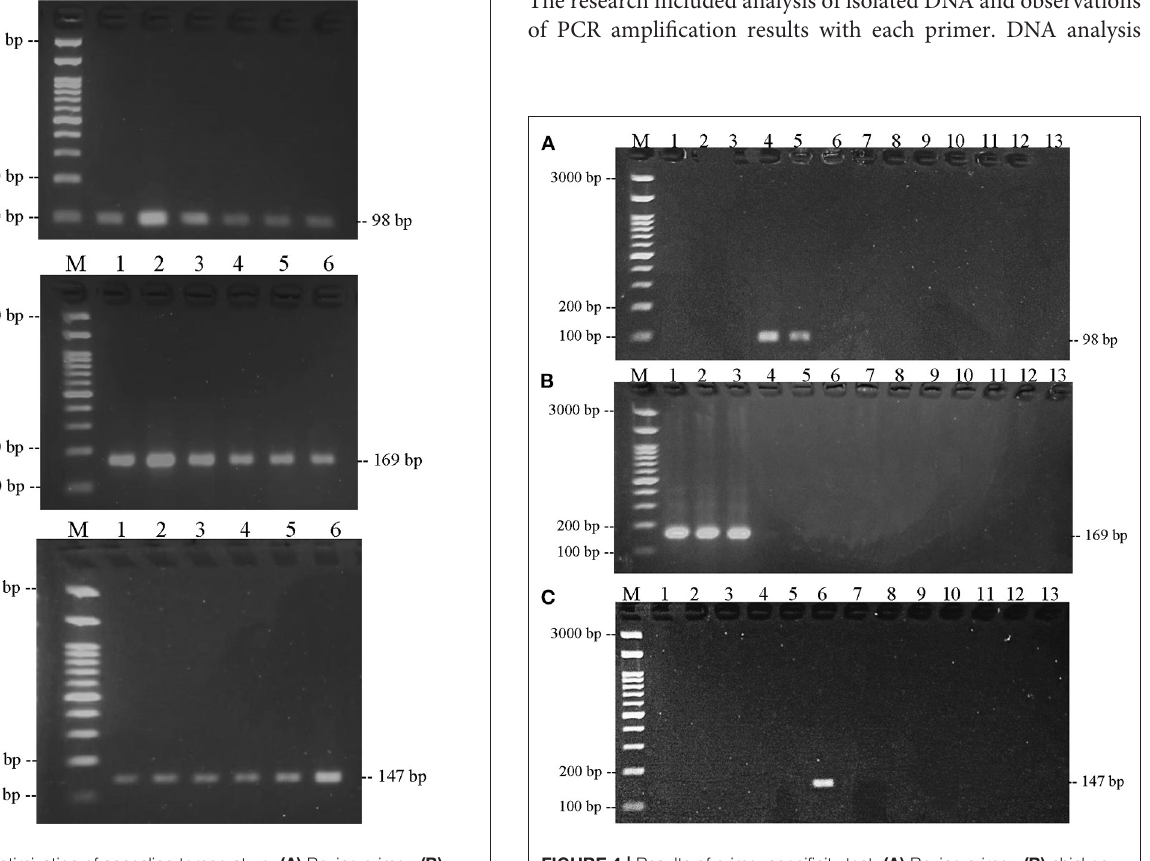
FIGURE 3 | Optimization of annealing temperature. (A) Bovine primer; (B) chicken primer; and (C) pork primer at various temperatures, electrophoresed on 2% agarose gel. (M) DNA marker 100 bp. (1) Temperature 54 ◦ C; (2) temperature 55 ◦ C; (3) temperature 56 ◦ C; (4) temperature 57 ◦ C; (5) temperature 58 ◦ C; (6) temperature 59 ◦ C.